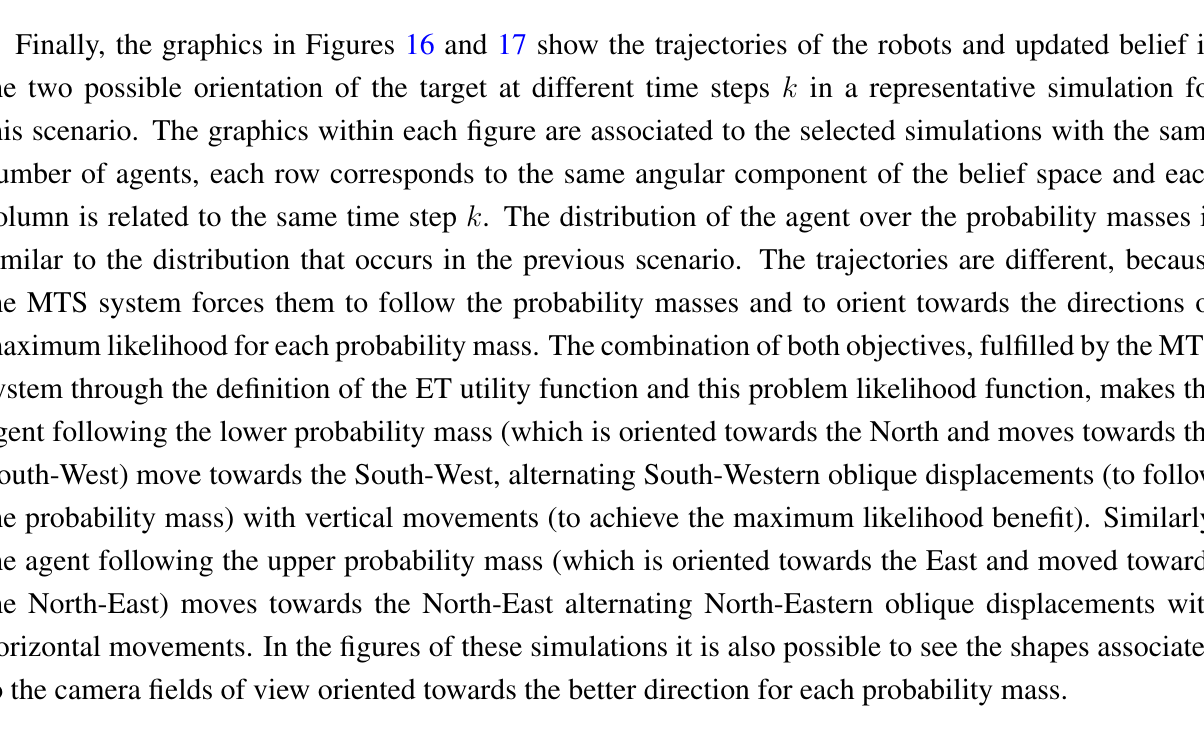
Figure 16. Simulated results in the dynamic camera scenario with M = 1 agent. ( a ) North, k = 10 ; ( b ) North, k = 20 ; ( c ) North, M = 1 , k = 30 ; ( d ) East, k = 10 ; ( e ) East, k = 20 ; ( f ) East, k = 30